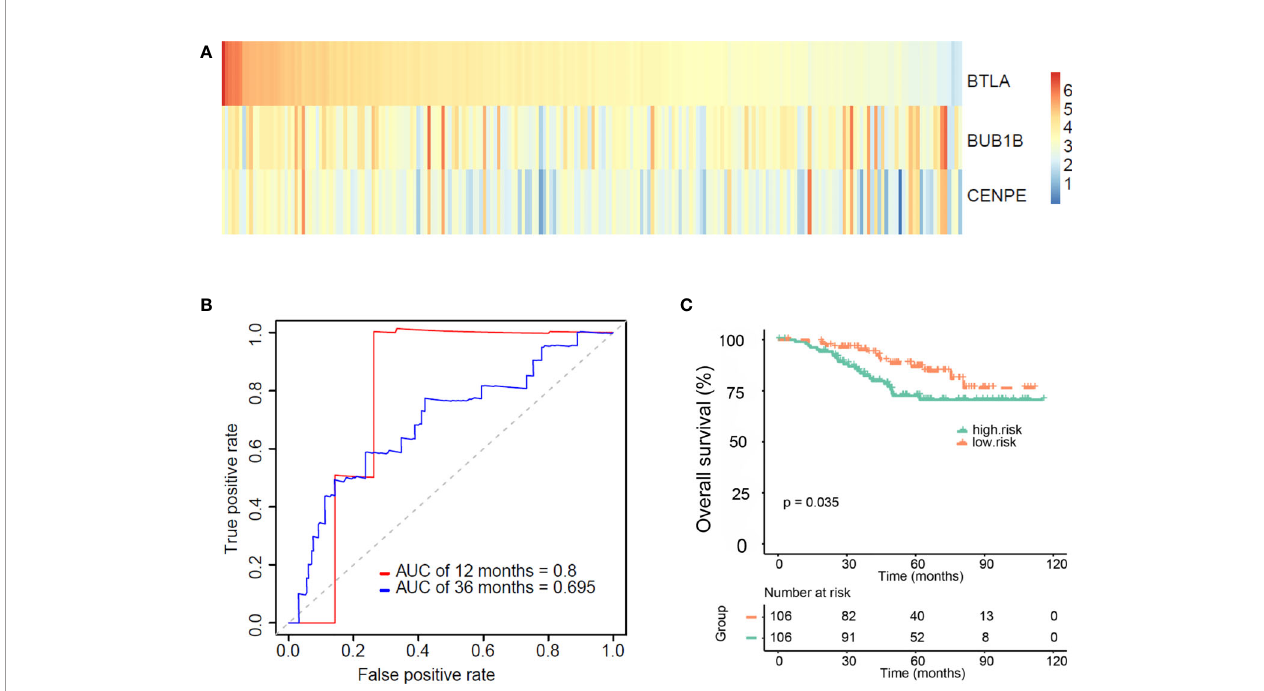
FIGURE 5 | Validating the validity and reliability of the gene signature in four external datasets (GSE31210, GSE26939, GSE72094, and GSE11969). (A) Heat map of three gene expressions (BTLA, BUB1B, and CENPE). (B) Receiver operating characteristic curves of the gene signature at 12 months and 36 months. (C) Kaplan – Meier curves for overall survival (OS) in the high and low-risk groups and number of